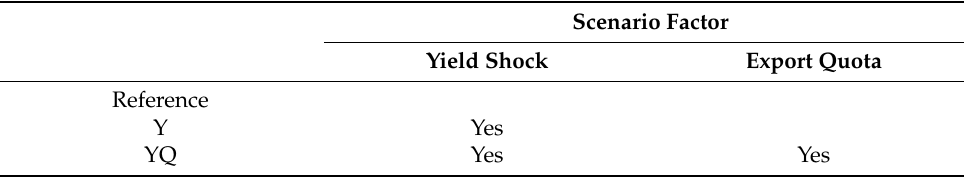
Table 3. Scenario